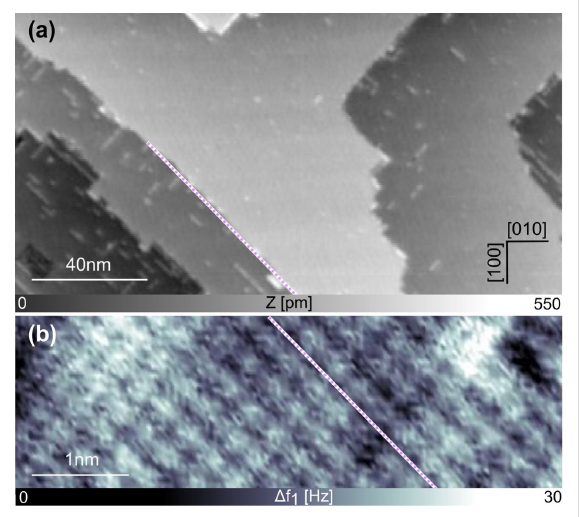
Figure 2: The surface of NiO(001). (a) Large-scale topographic image of the NiO(001) crystal showing clean terraces running along the [110] direction of the surface (scan parameters: = 4 nm, Δ f 1 = − 9 Hz). (b) Frequency-shift ( Δ f 1 ) signal of the same surface at atomic resolu- tion, recorded in the second line scan of the multipass technique with following scan parameters: = 4 nm, Δ f 1 = − 42 Hz) and z offset = − 700